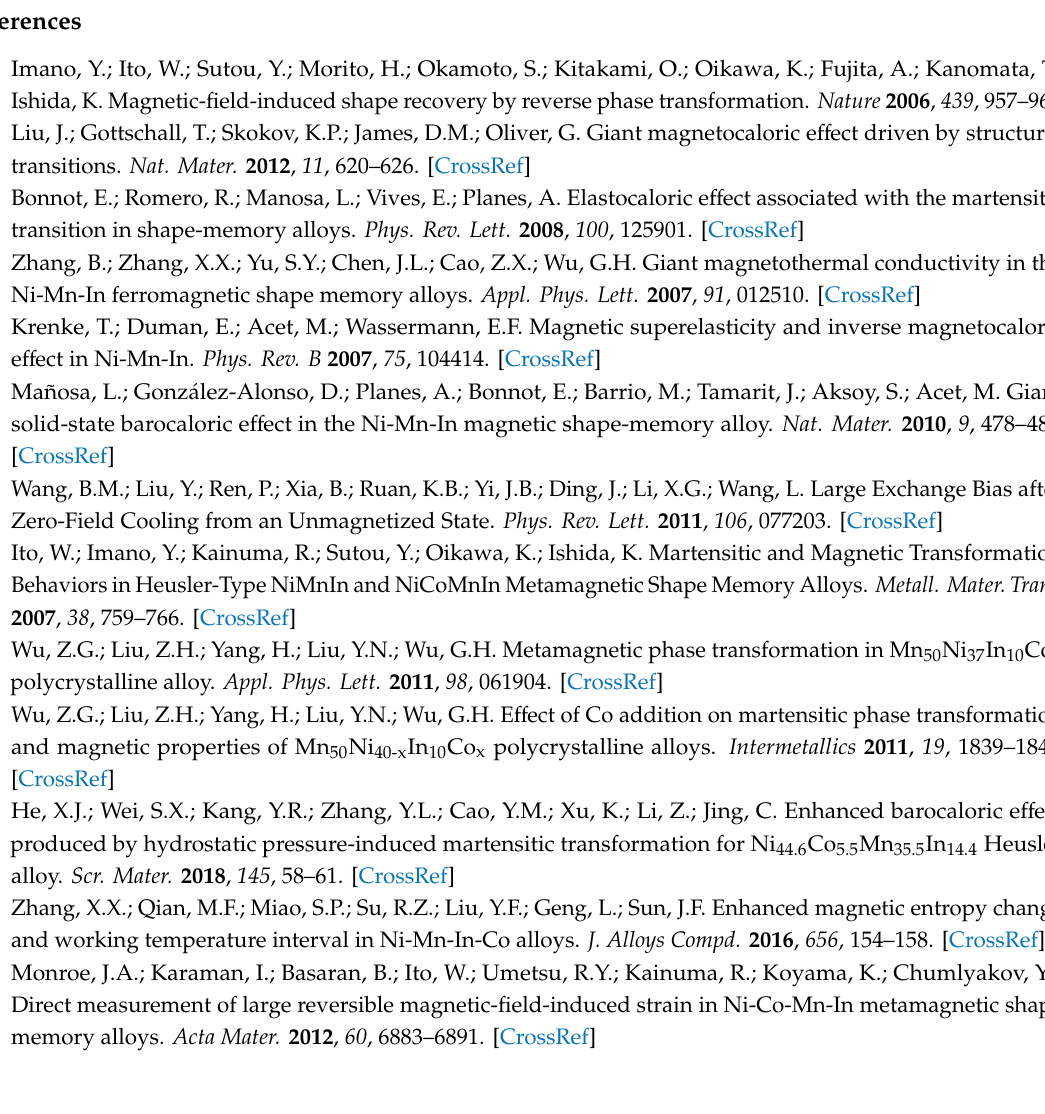
Table S1: XRD and SEM / EDS analysis results of the selected Co-Ni-In samples at 673 K, Table S2: XRD